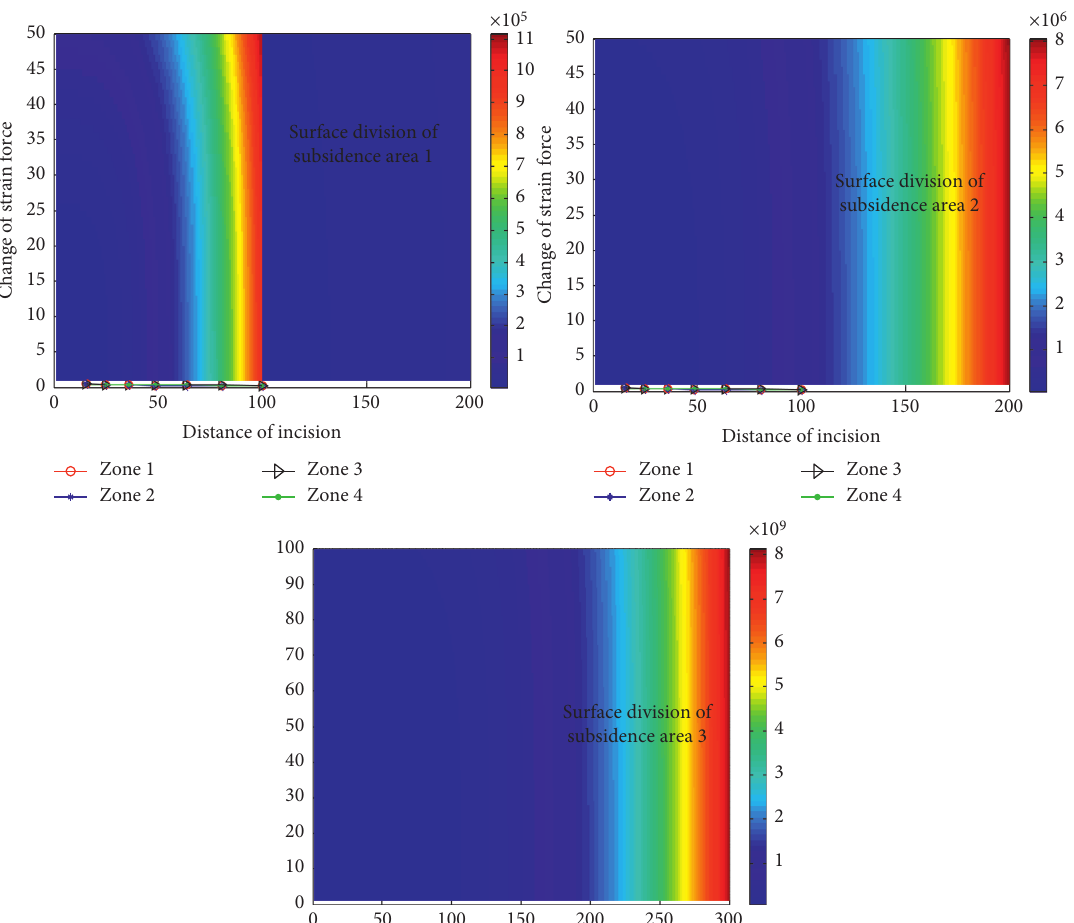
Figure 9: Processing map of distance between surface working face and cut hole in subsidence area ( d �